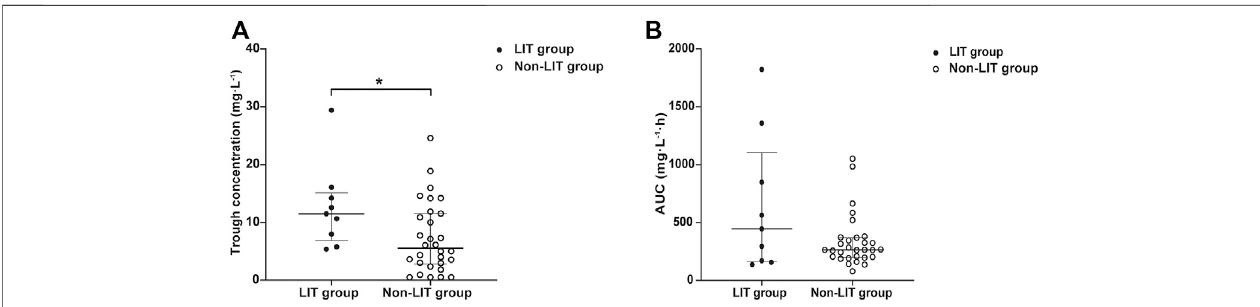
FIGURE 6 | (A) Distribution of LZD initial trough concentration in the LIT group and non-LIT group. Compared with the non-LIT group, trough concentration was signi fi cantly higher in the LIT group [11.49 (6.86, 15.13) vs . 5.51 (2.80, 11.61), * p = 0.027]. (B) Distribution of LZD AUC 24h in the LIT group and non-LIT group.